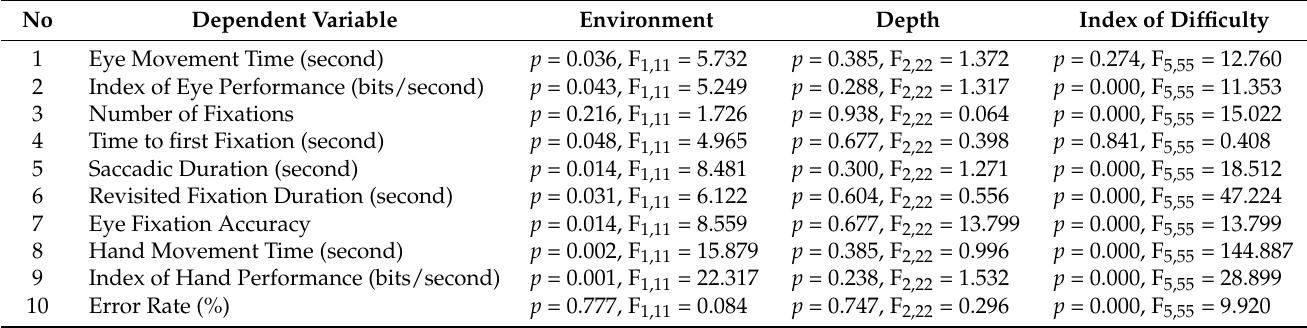
Table 13. Summary of the